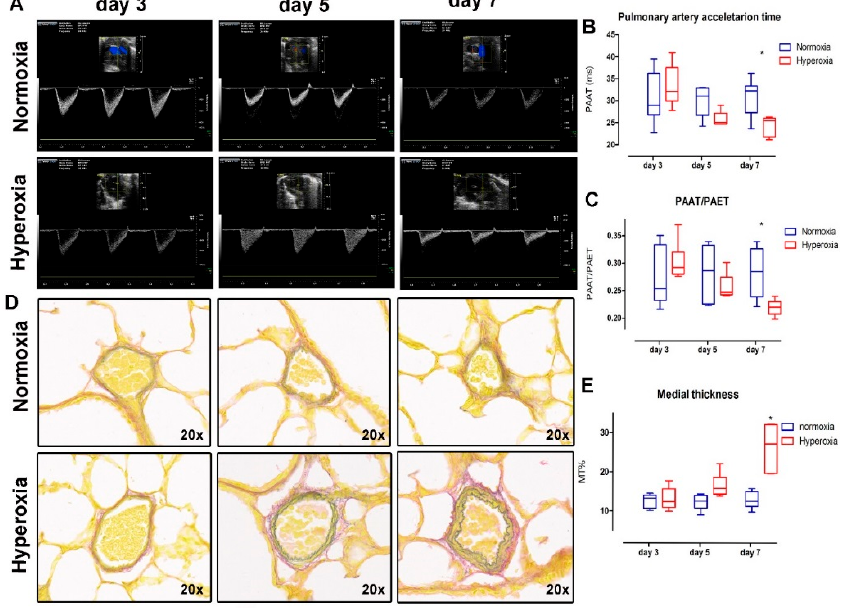
Figure 1. Pulmonary artery micro-ultrasound and lung peripheral arteries media thickness: ( A ) Representative images of micro-ultrasound scans of pulmonary artery Doppler showing a progressive decrease of pulmonary artery acceleration time (PAAT) and PAAT/pulmonary artery ejection time (PAET) ratio in the hyperoxia group; ( B ) PAAT; ( C ) PAAT/PAET; ( D ) Representative images of lung peripheral arteries showing progressive thickening of tunica media in hyperoxia group pups; ( E ) Media thickness (MT%) of lung peripheral arteries. * = Significant interaction between time and group in two-way ANOVA; significant difference between studied groups in day seven. n = 6 per time point in each group.